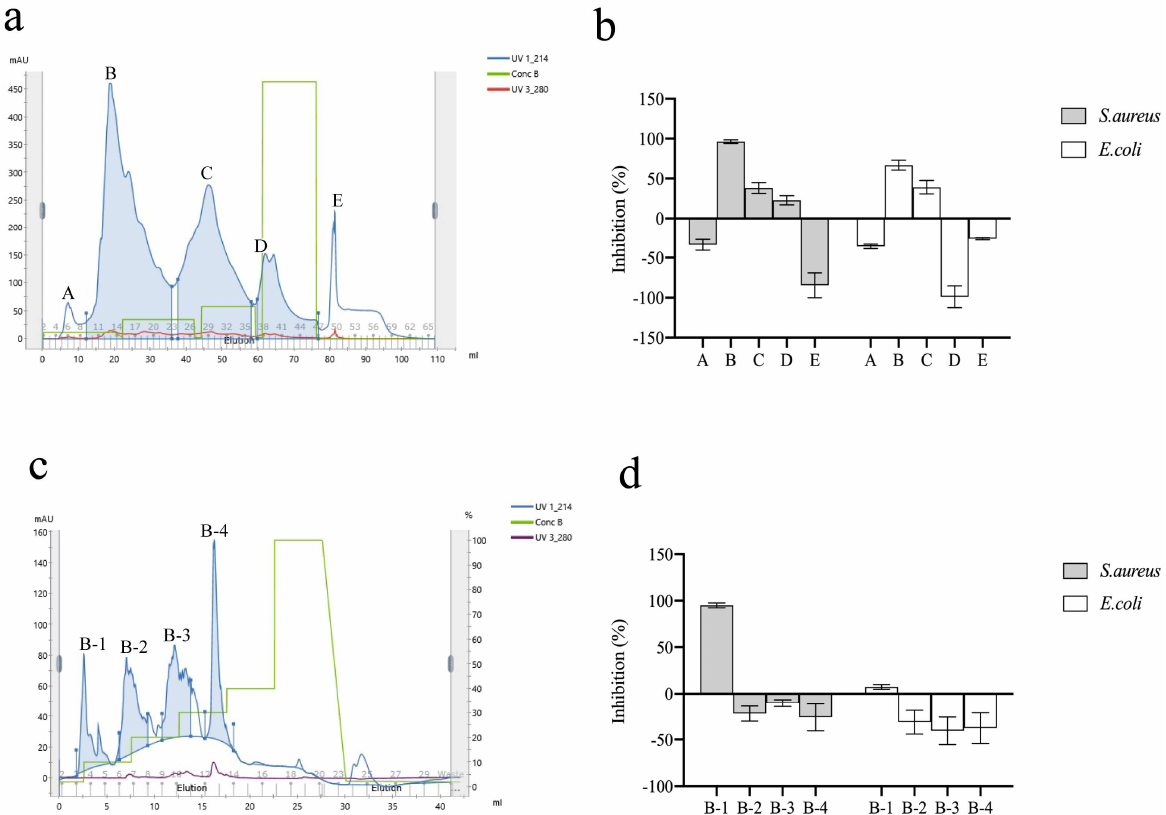
Figure 1. ( a ) Size exclusion chromatography of peptides from CPH (A-E are peptide peaks ); ( b ) The antibacterial activities of different peptide fractions obtained by size − exclusion chromatography (4 mM L − Leu equivalents); ( c ) RPC of peptides from Peak B; ( d ) The antibacterial activities of different peptide fractions obtained by RPC (2 mM L − Leu equivalents). Data are presented as the mean ± SD, n = 3 .